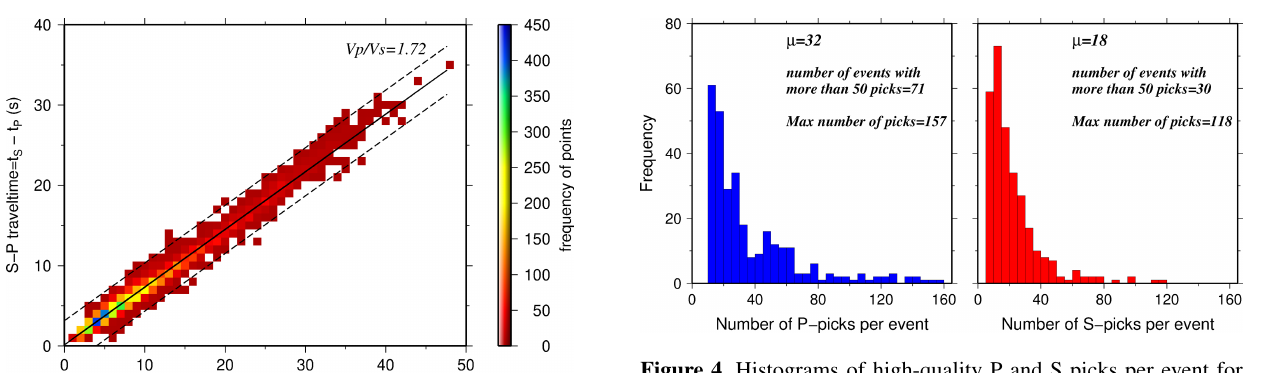
Figure 4. Histograms of high-quality P and S picks per event for 301 well-constrained local earthquakes used for simultaneous inver- sion of hypocenters, 1-D velocity models, and station corrections. The average number of picks per event is 32 for P and 18 for S, with maximum of 157 and 118, respectively (Fig.